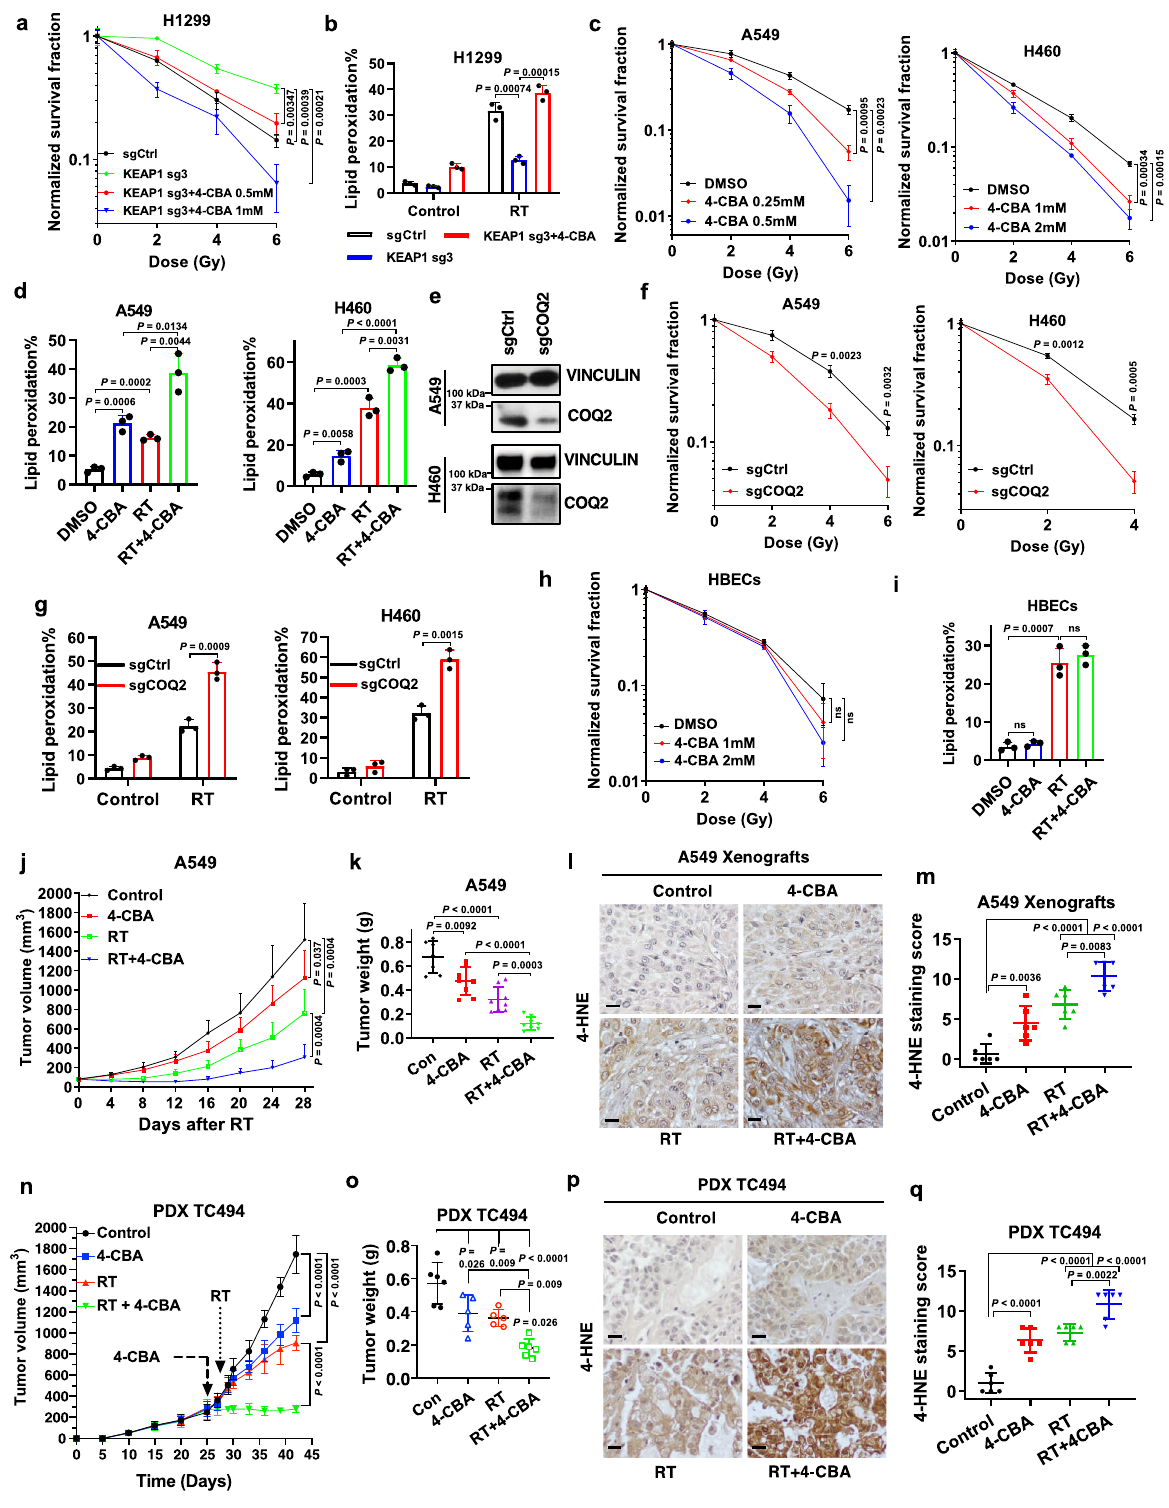
Western blotting . Western blotting was conducted as previously described 66,67 . Cell lysates were prepared in NP40 buffer as previously described 68 . The primary antibodies and concentrations used for Western blotting were following: KEAP1 (Santa Cruz, sc-365626, 1:1000 dilution), FSP1 (1:1,000, Proteintech, no.